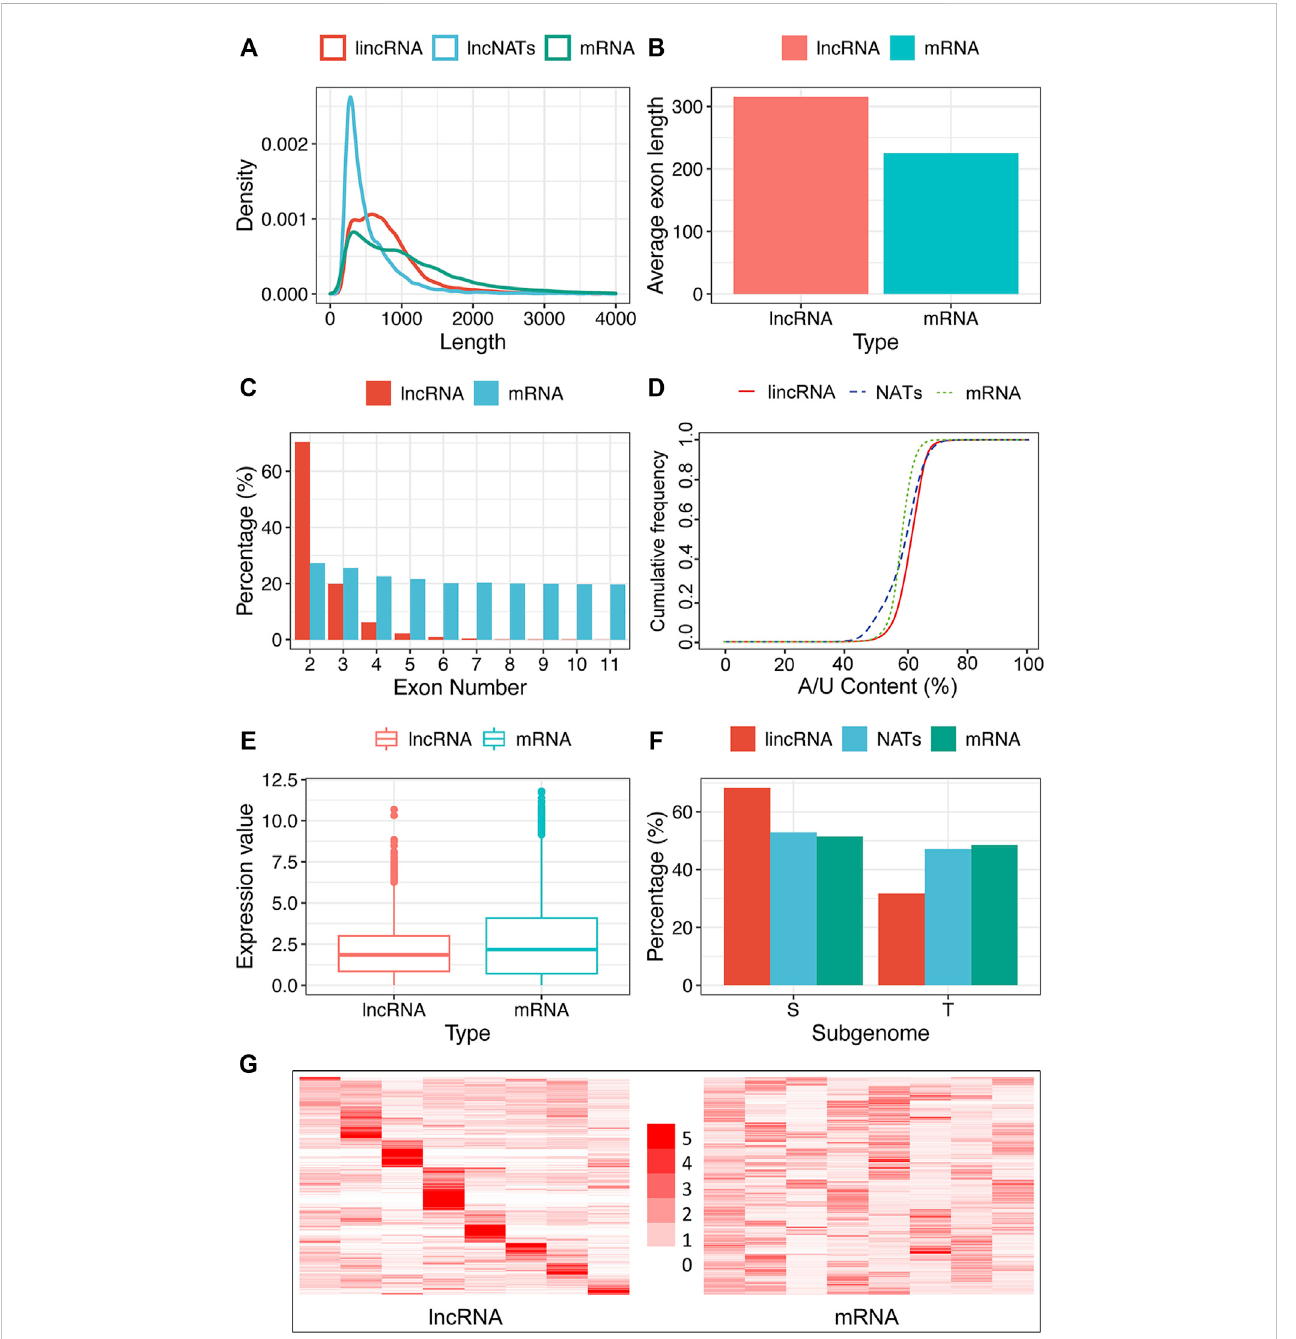
FIGURE 2 CharacteristicsoftobaccolncRNA. (A) Length distributionof coding genes(mRNAs), lincRNAs,and NATs, (B) Average exon length oflncRNA and mRNA, (C) Exon number of mRNAs, lincRNAs, and NATs, (D) A/U content of mRNAs, lincRNAs, and NATs, (E) Expression boxplot of mRNAs and lncRNAs, (F) Sub- genome dominance percentage of mRNAs, lincRNAs, and NATs between two ancestors, Nicotiana sylvestris (S) and Nicotiana tomentosiformis (T), (G) Tissue ’ sexpressionheatmapoflncRNAsandmRNAsclustered byrow.TherowrepresentsTPM ’ sfoldchangerelativetothesub-largestvalueintherow, and the column represents different tissue (From left to right are the tissues of the fl ower, root, dry capsule, anther, petal, leaf, stem and seed). Regarding the signi fi cant difference test, we used the t -Test method in fi gures b and e with a p -value of 0.05 and Pearson ’ s Chi-squared Test in fi gure f with a p -value of 1.0